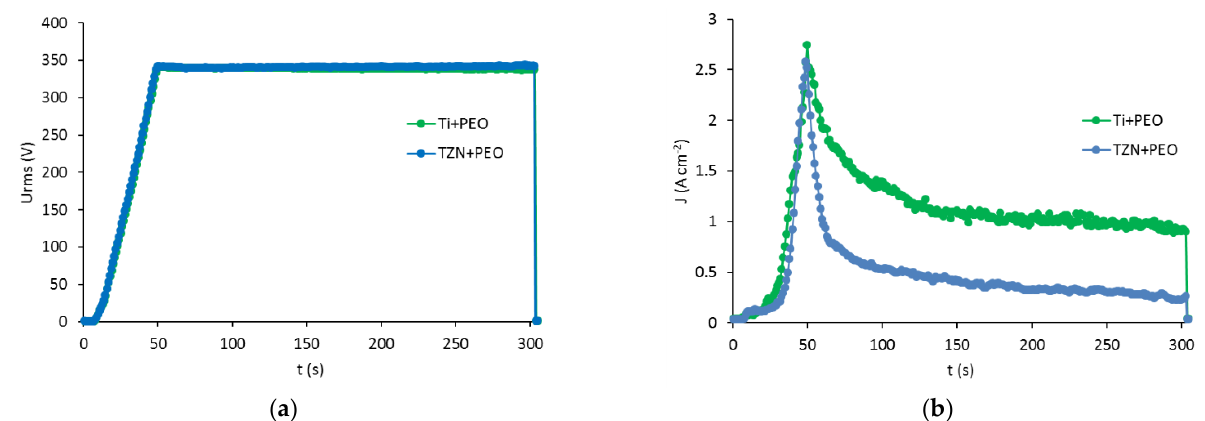
Figure 1. Electrical characteristics for the plasma electrolytic oxidation (PEO) process of Ti and Ti-18Zr-15Nb (TZN) samples: ( a ) root mean square (RMS) voltage; ( b ) RMS current density .